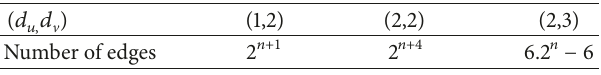
Table 2: Edge partition of propyl ether imine dendrimers based on degree of end vertices of each